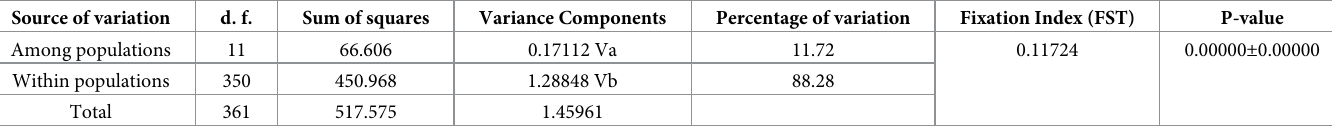
Table 2. AMOVA analysis of I1 cattle of Andaman and different regions of Indian subcontinent and Island Southeast Asian countries. Source of variation d.